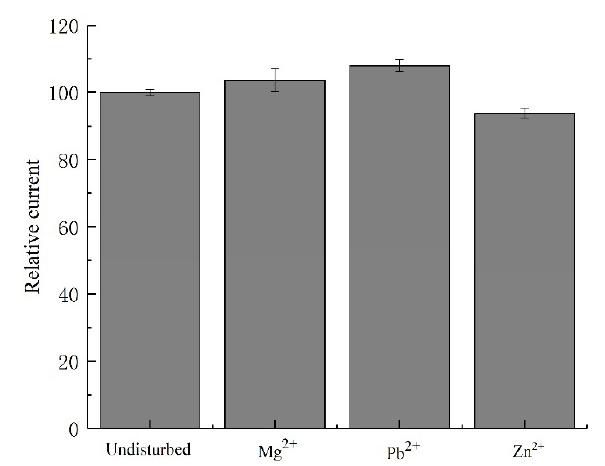
Figure 10. Influence of different interfering ions on response current.